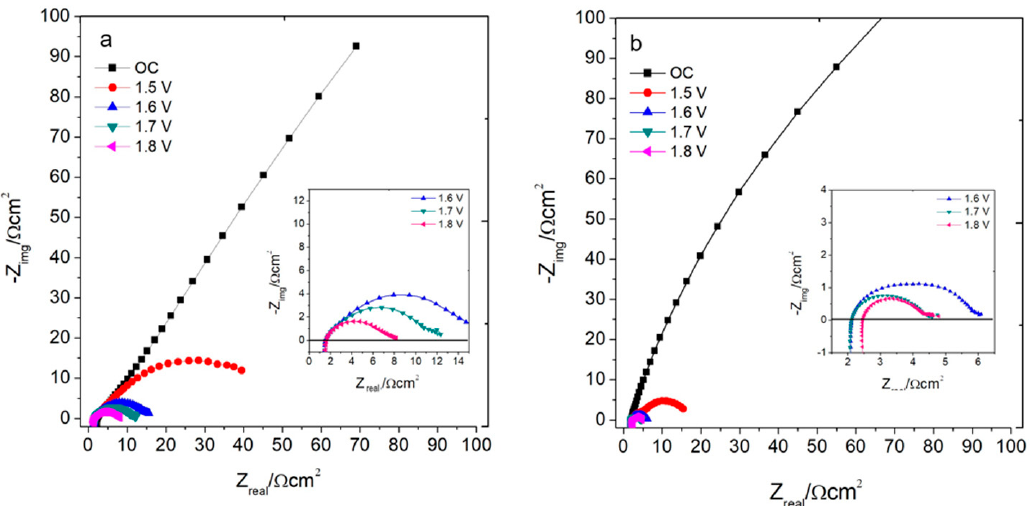
Figure 9. Electrochemical impedances spectra of ( a ) IrO2 / ATO and ( b ) Ir-Sn-Sb-O.